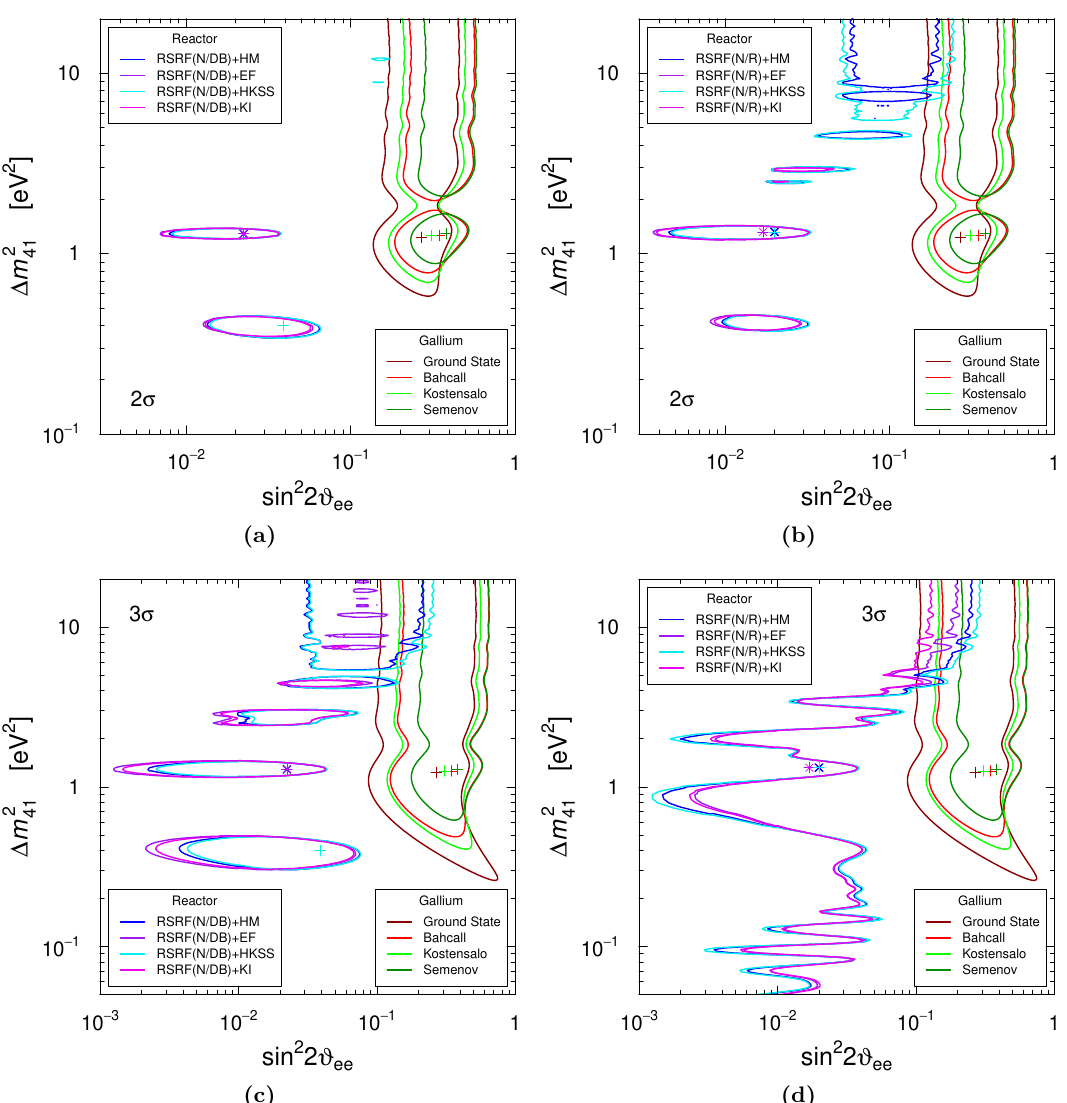
Figure 5. Comparison of the contours delimiting the [(a) and (b)] 2 σ and [(c) and (d)] 3 σ allowed regions in the ( sin 2 2 ϑ ee , ∆ m 2 ) plane obtained from the combined analysis of the data of the reactor 41 rate experiments with different flux models and the spectral ratio experiments with those obtained from the Gallium data with different cross sections. The figures differ by the use of [(a) and (c)] NEOS/Daya Bay [45] or [(b) and (d)] NEOS/RENO [46] spectral ratio data. The best-fit points are indicated by